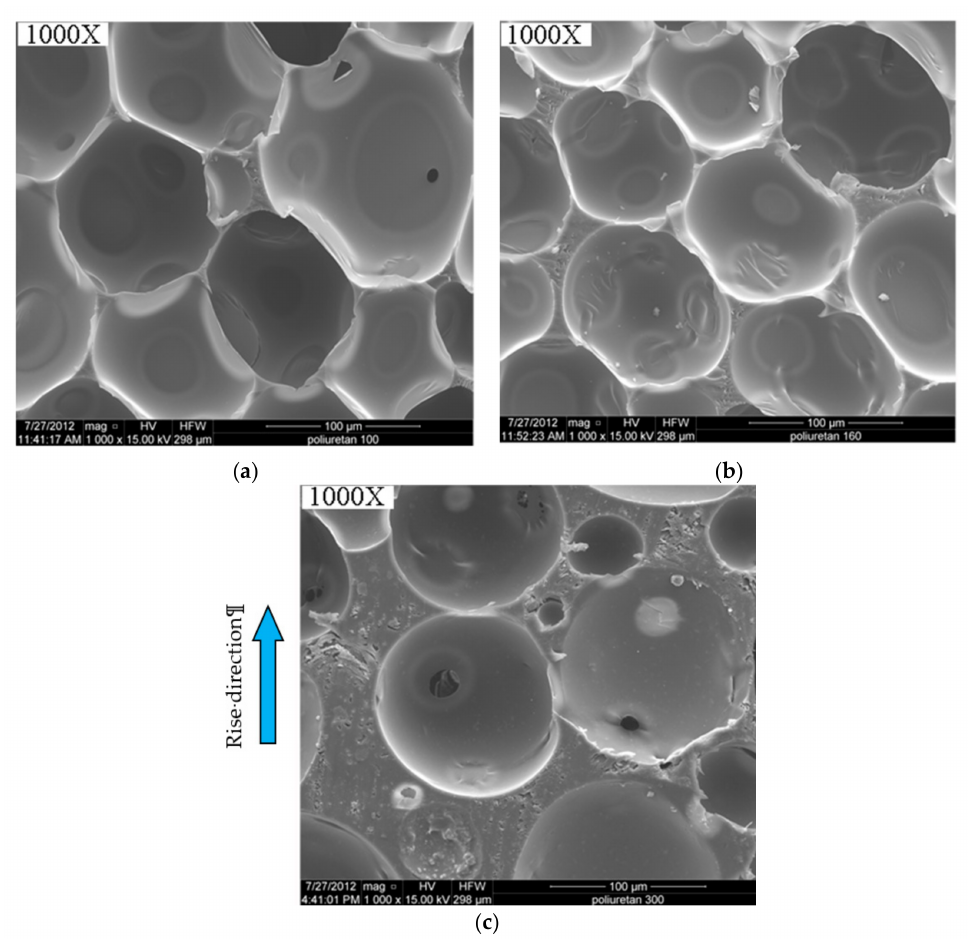
Figure 3. Microstructures of the investigated foams for 100 ( a ); 145 ( b ) and 300 ( c ) kg / m 3 .